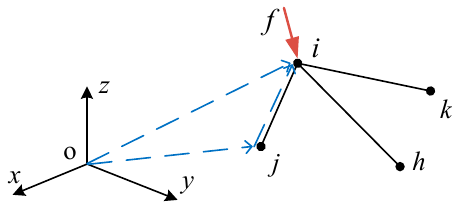
Figure 2. The distribution of the nodes.